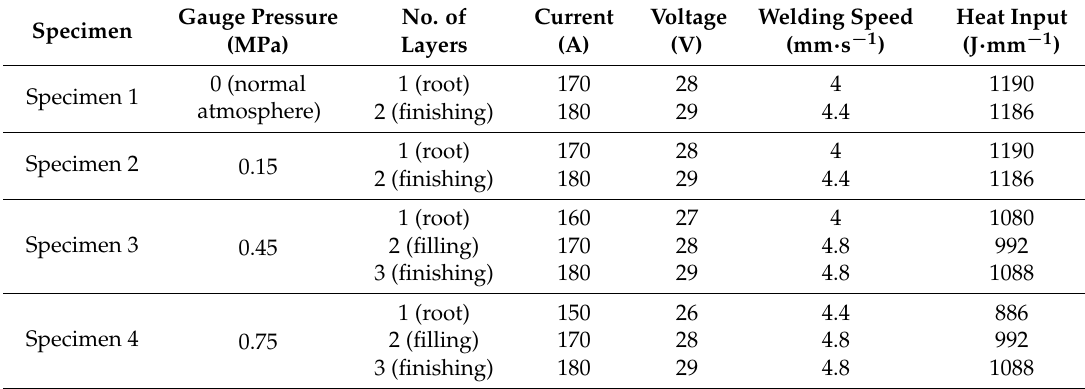
Table 2. Welding parameters used in underwater dry hyperbaric multi-pass